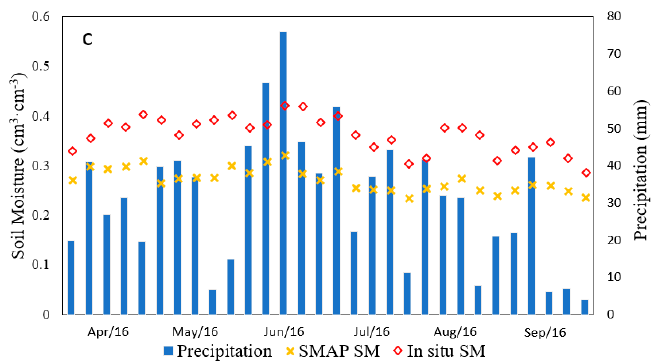
Figure 6. Time series plots of the SMAP L3 SM data and the in situ SM over ( a ) region 1, ( b ) region 2 and ( c ) region 3. Variable Soil Moisture and Precipitation represent the 7-day averaged SM and 7-day accumulated precipitation, respectively. 30 groups of data (i.e., SMAP SM, in situ SM and precipitation) were used from 1 April 2016 to 30 September 2016. It shows that the rainfall results in increases in SM, and SMAP SM can generally reflect these dynamics.